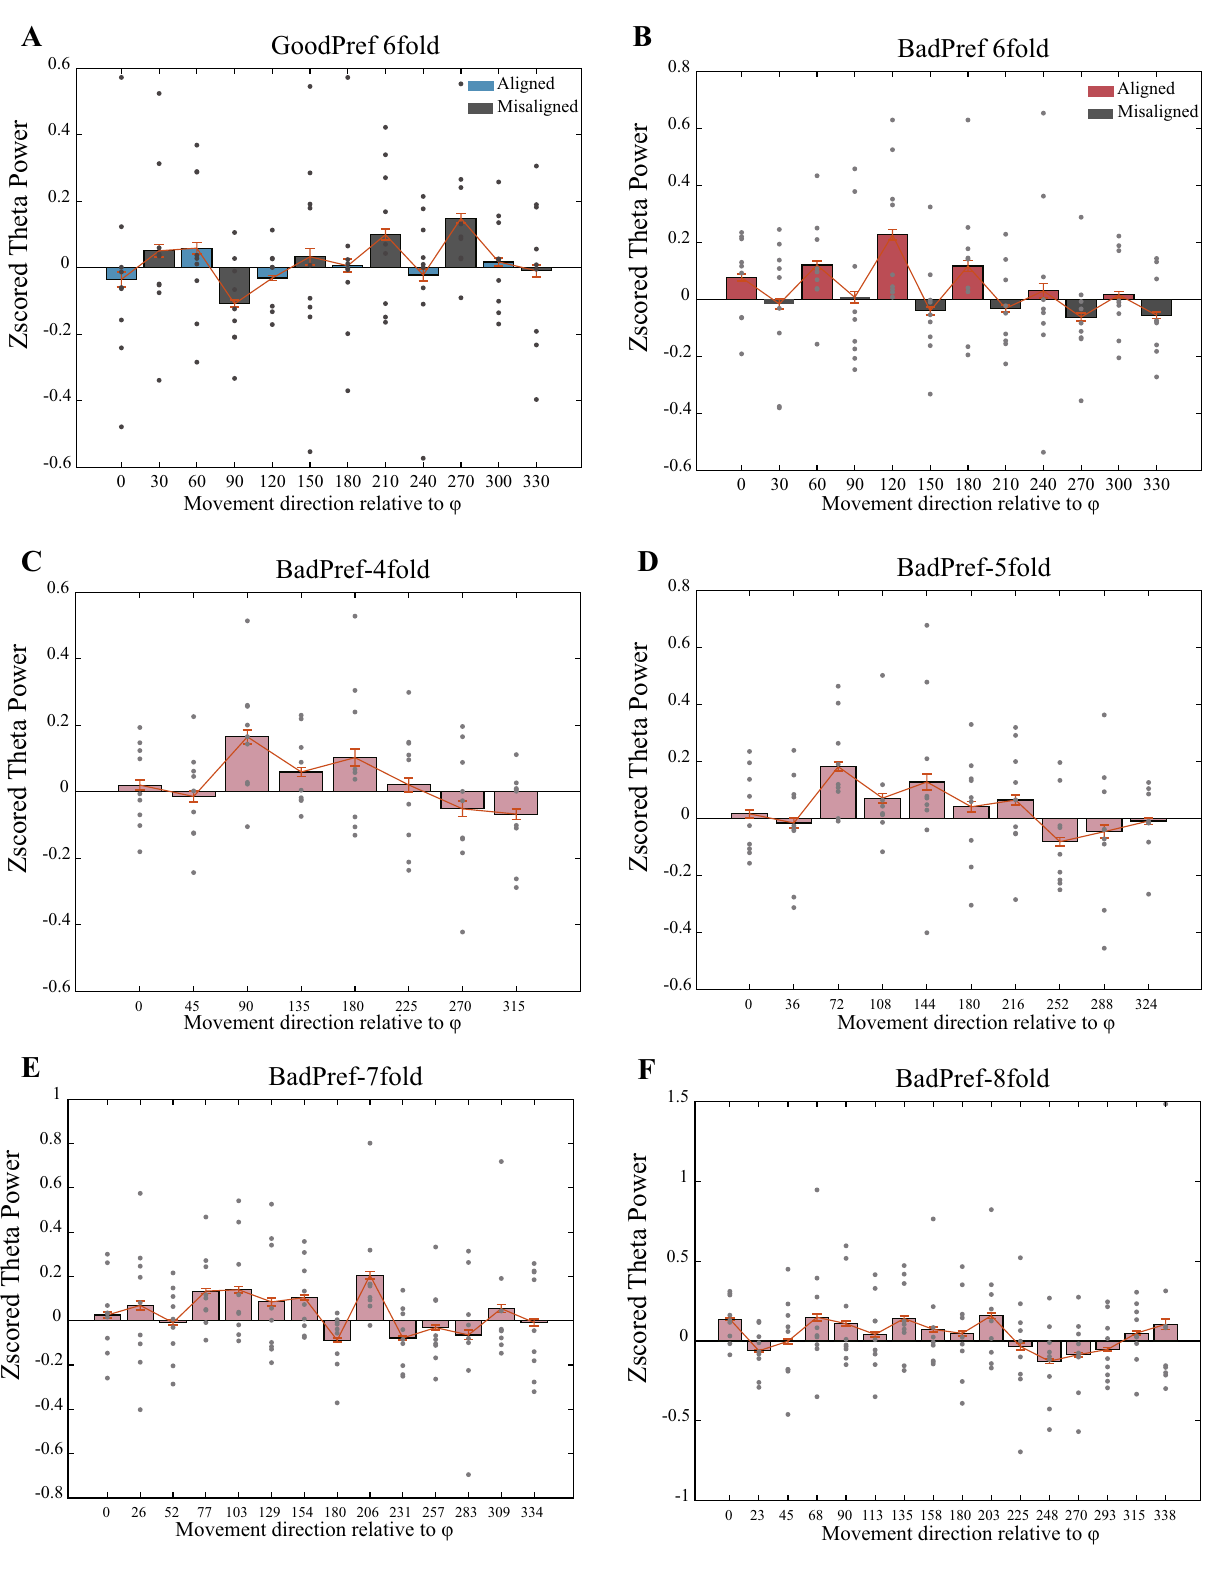
Figure 3. Theta power comparison in the case of movements aligned and misaligned with the grid axe of periodic symmetry. ( A ) Theta power of sixfold symmetry in GoodPref. ( B ) Theta power is higher during movements aligned with the grid axes as compared to misaligned movements. of sixfold symmetry in BadPref. ( C – F ) Theta power under other rotation symmetries (4/5/7/8-fold) in BadPref did not show the alternating trend of the high and low differences between aligned and